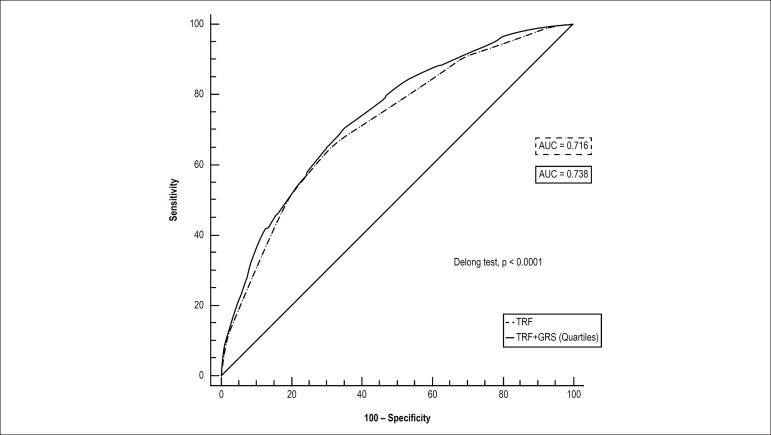
ROC curves based on the baseline model (traditional risk factors,
TRFs) and after adding the genetic risk score (GRS) (quartiles) in
predicting the risk for coronary artery disease. The two curves are
based on logistic regression models incorporating conventional risk
factors (diabetes, dyslipidemia, smoking and hypertension) with and
without the GRS. AUC indicates area under curve. The Delong test
compares the difference between the two AUCs (p < 0.0001).